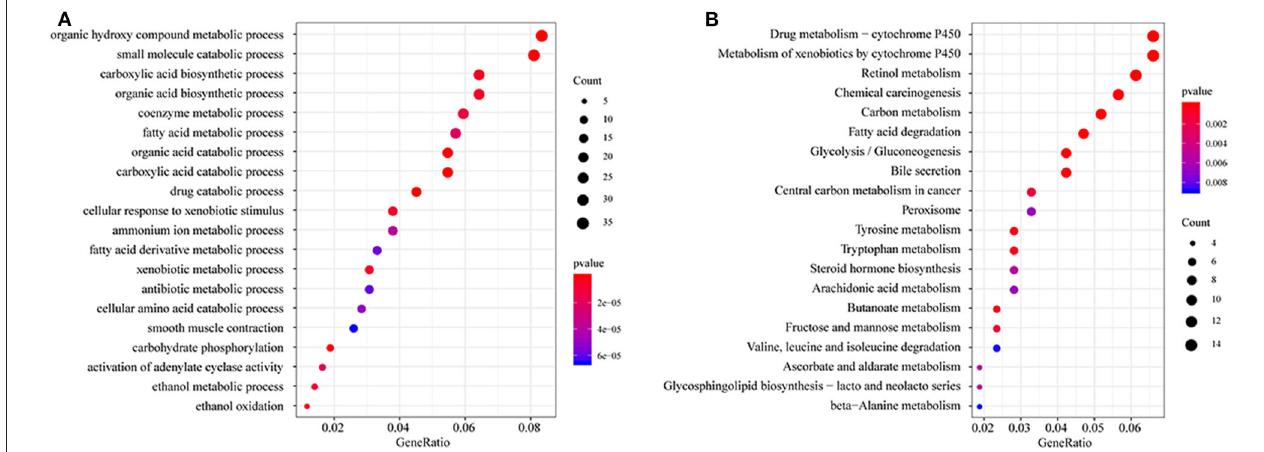
FIGURE 3 | Functional enrichment analysis of differentially expressed genes (DEGs). (A) GO enrichment analysis results, showing only the first 20 terms; (B) KEGG pathway enrichment analysis results, showing only the first 20 pathways. GeneRatio: refers to the ratio of the number of genes enriched in the term/pathway to the total number of genes in the term/pathway.